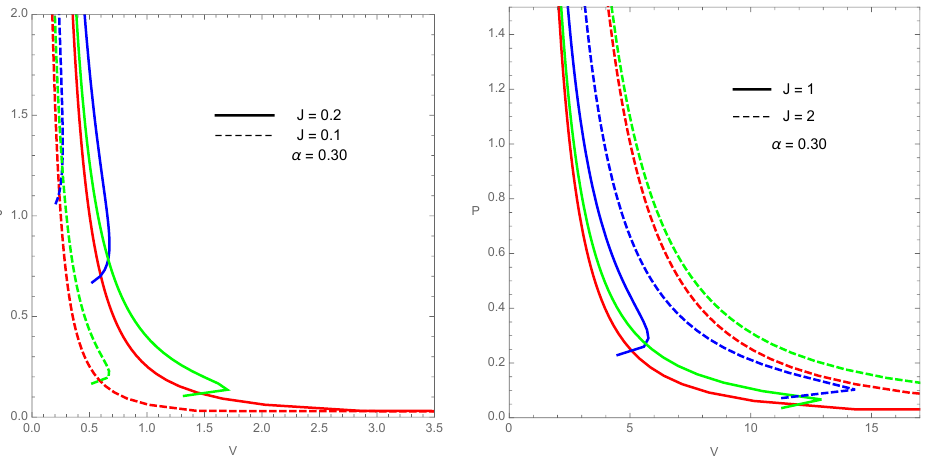
Figure 4 . PV diagram for (cid:11) = 0 : 30, (cid:13) = 0 : 70, J = 0 : 1 ; 0 : 2 ; 1 ; 2, and T = 0 : 001 (red), T = 0 : 5 (green), T = 2